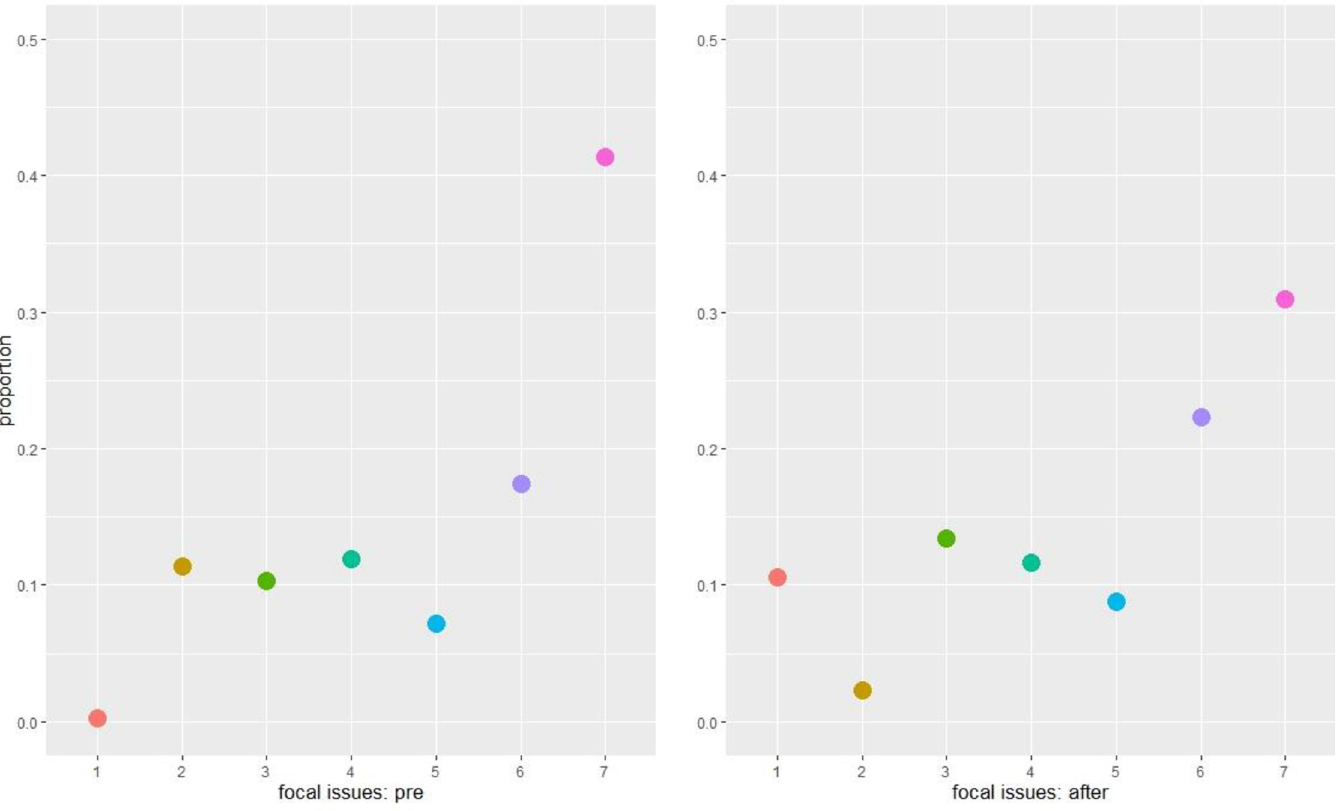
Fig 6. Proportions of focal issues mentioned in the tweets of the 115 major police departments in the U.S. before and after the killing of George Floyd on May 25 th , 2020. Focal issues: (1) civil unrest related; (2) COVID-19 related; (3) police gathering of information; (4) police communication of administrative and mundane information; (5) police communication of traffic information; (6) police communication of case updates; and (7) community engagement and